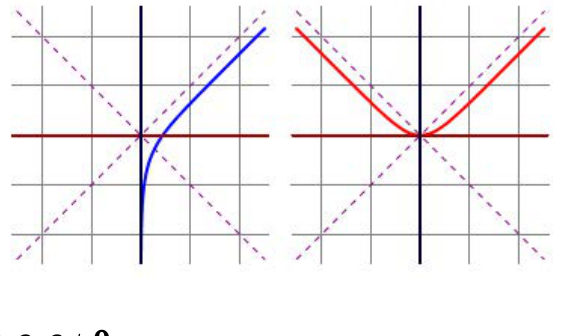
Fig. 15. Curves with K( y ) = e y ; spacelike (left), timelike